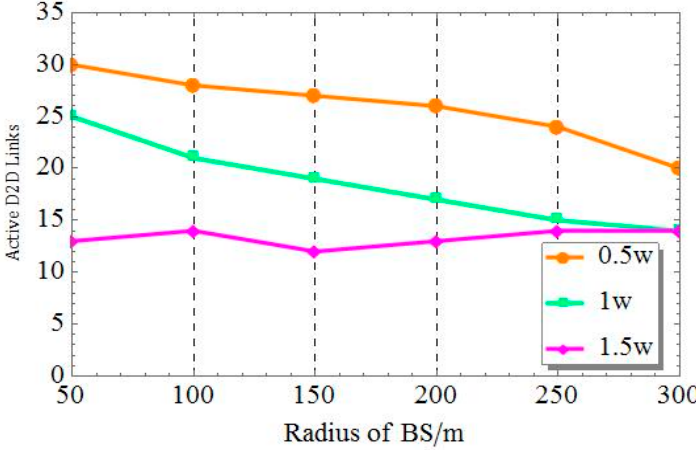
Figure 9. The number of active D2D links under different radii and different base station powers.